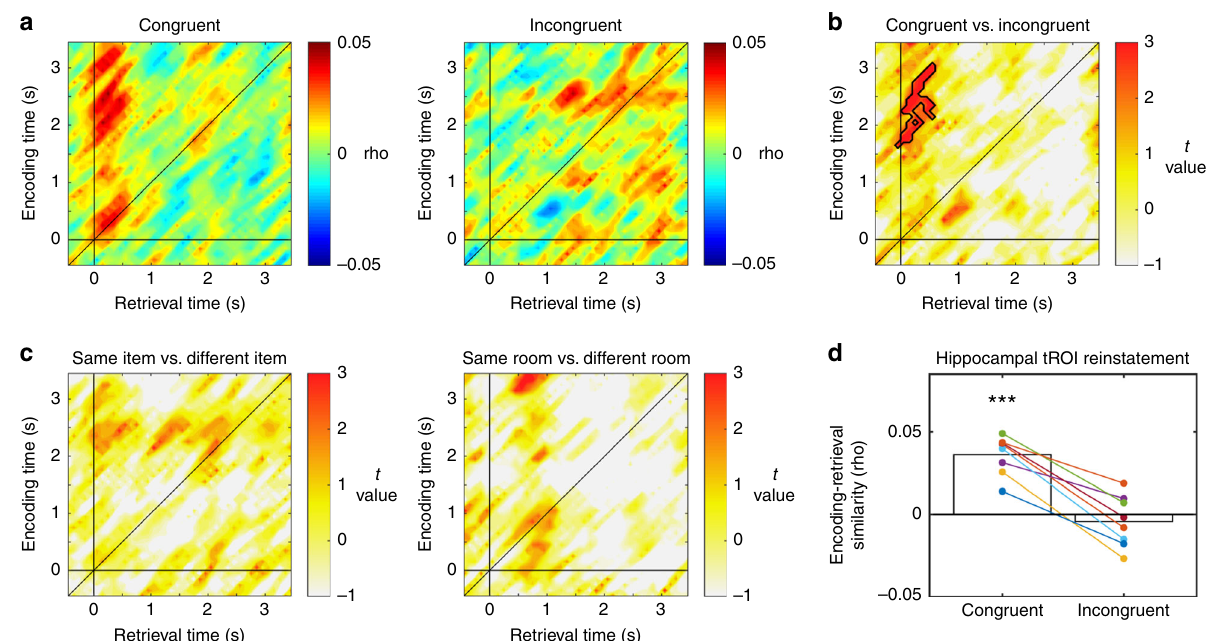
Fig. 2 Reinstatement of item-context associations in the hippocampus. a Grand average reinstatement map for congruent (left) and incongruent (right) trials in the hippocampus, where the same item is viewed in either the same or a different context (room) during retrieval. b T -map of the congruent vs. incongruent contrast reveals a signi fi cant cluster at p (corr) < 0.05 (outlined in black), indicating that HC reinstatement represents the binding of item- context information. c Reinstatement of same vs. different items regardless of context (left) and same vs. different contexts regardless of item (right): no signi fi cant clusters. d Reinstatement in the congruent and the incongruent conditions in the signi fi cant cluster in b tested against zero (one-sample t -test); colored dots indicate individual subjects. *** indicates p <